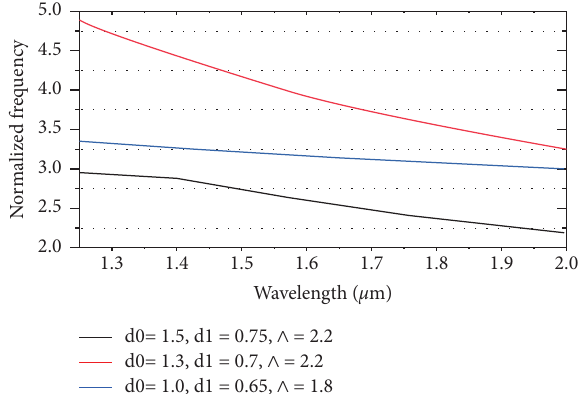
Figure 12: Variation in birefringence as a function of wavelength at Figure 14: Variation of normalized frequency as a function of � 1.5 μ m, and a pitch of Λ � 2.2 µ m for a constant air hole size of d 0 wavelength from 1.2 to 2 μ m in the PCF with 10 tiny air holes by the diferent PCF structures. varying the geometry of air holes. Table 2: ZDW in μ m for the proposed PCF by varying the diameter of bigger holes at a constant pitch of 2.2 μ